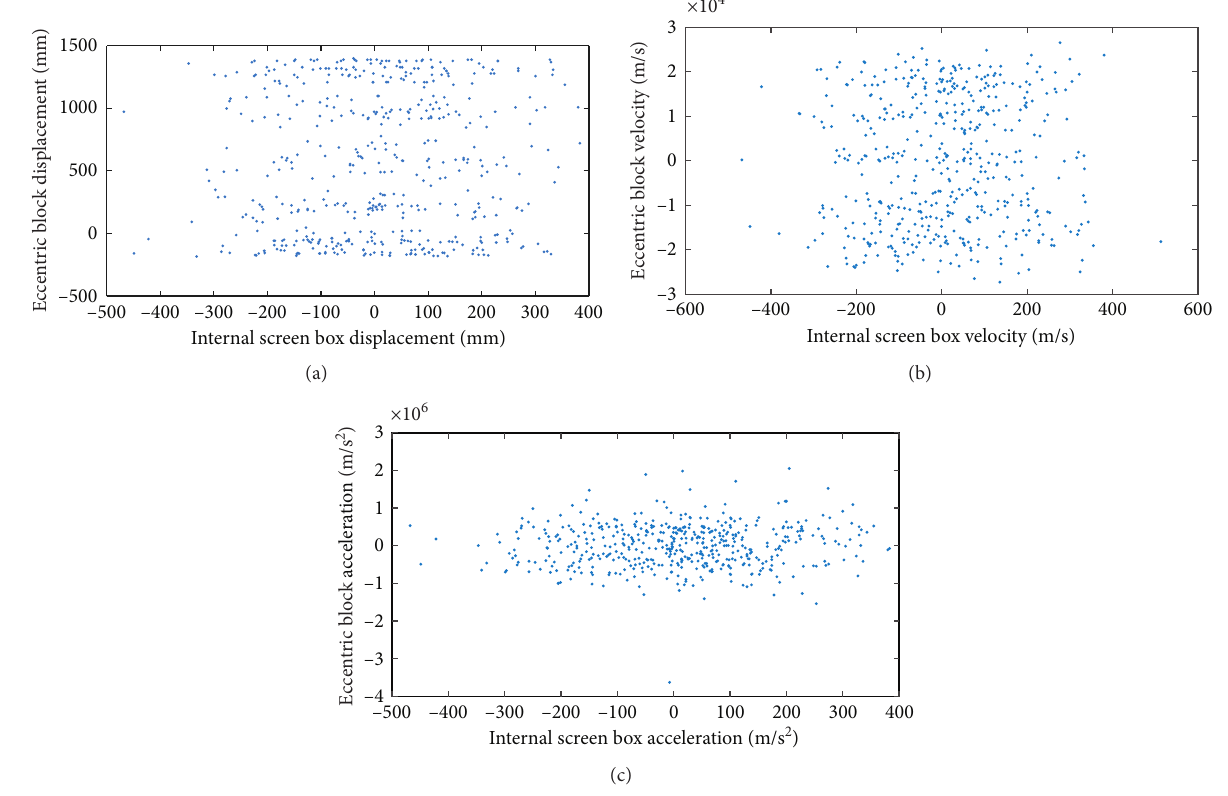
Figure 10: Phase trajectories of the eccentric block and inner screen box of the chaotic exciter. (a) Displacement phase trajectory, (b) velocity phase trajectory, and (c) acceleration phase